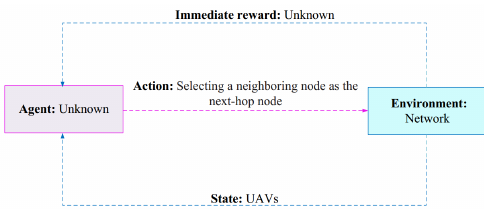
Figure 37. Learning process in QFL-MOR. Table 19. The most important advantages and disadvantages of